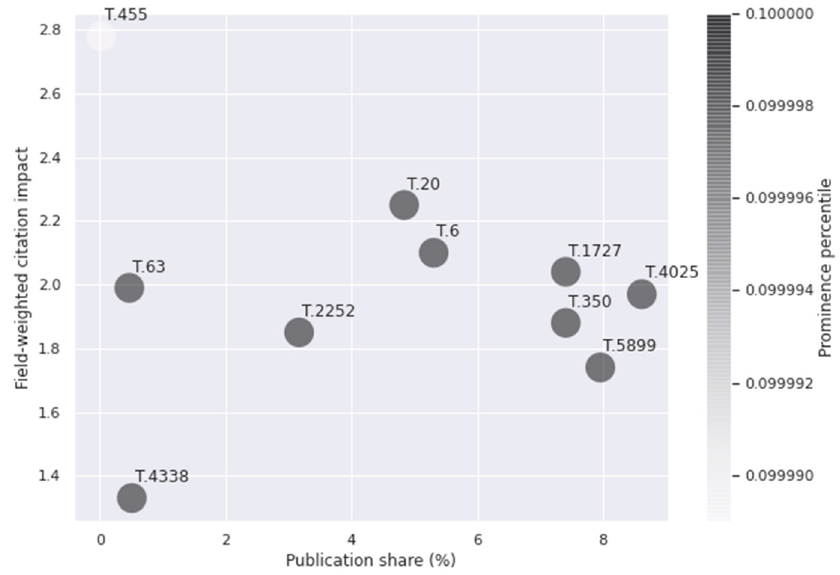
Figure 2. Top 10 topics by prominence that appear within renewable energy, sustainability and the